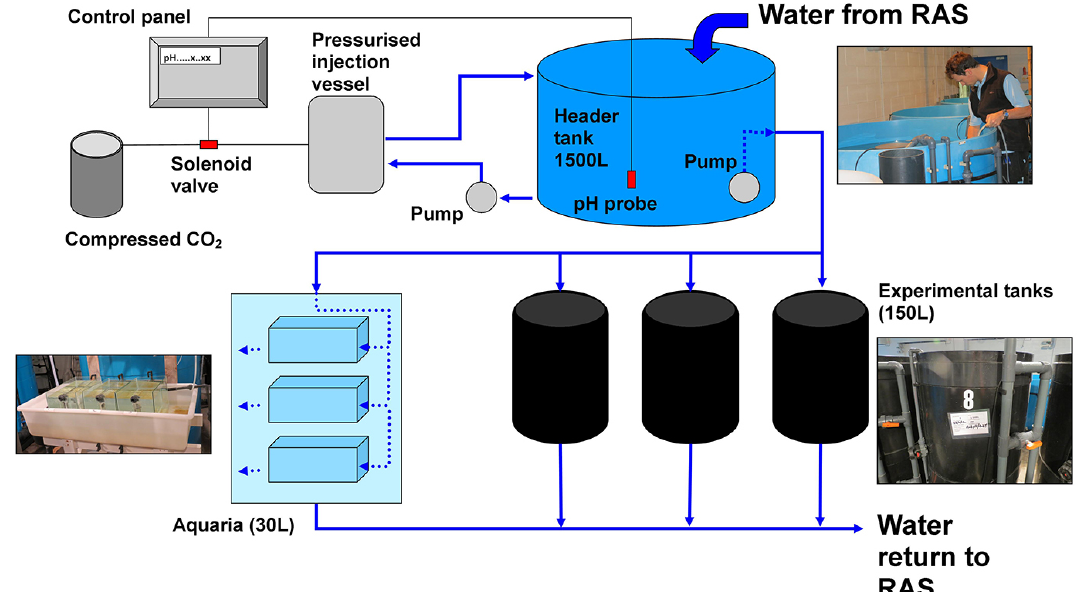
Fig. 1. Schematic of one of the four identical experimental systems used for the study; each maintained a different temperature/ p CO 2 combination. RAS=recirculating aquaculture